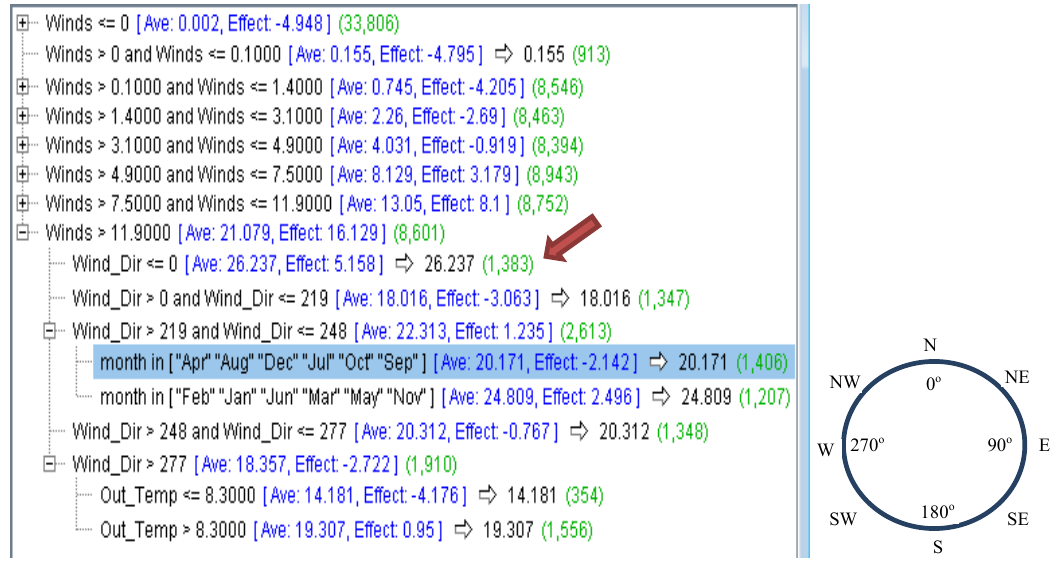
Figure 5. Corresponding CHAID rules for nodes 74-83 of Figure 4 relating to high gusts > 11.9 km/h.